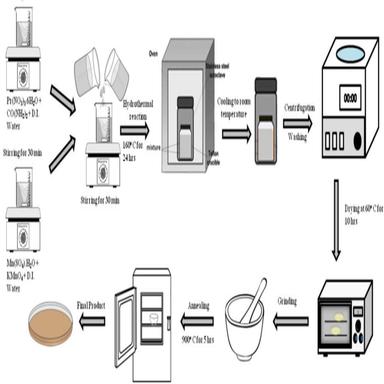
Schematic diagram of the synthesis of Pr6O11/Mn3O4 nanocomposites.